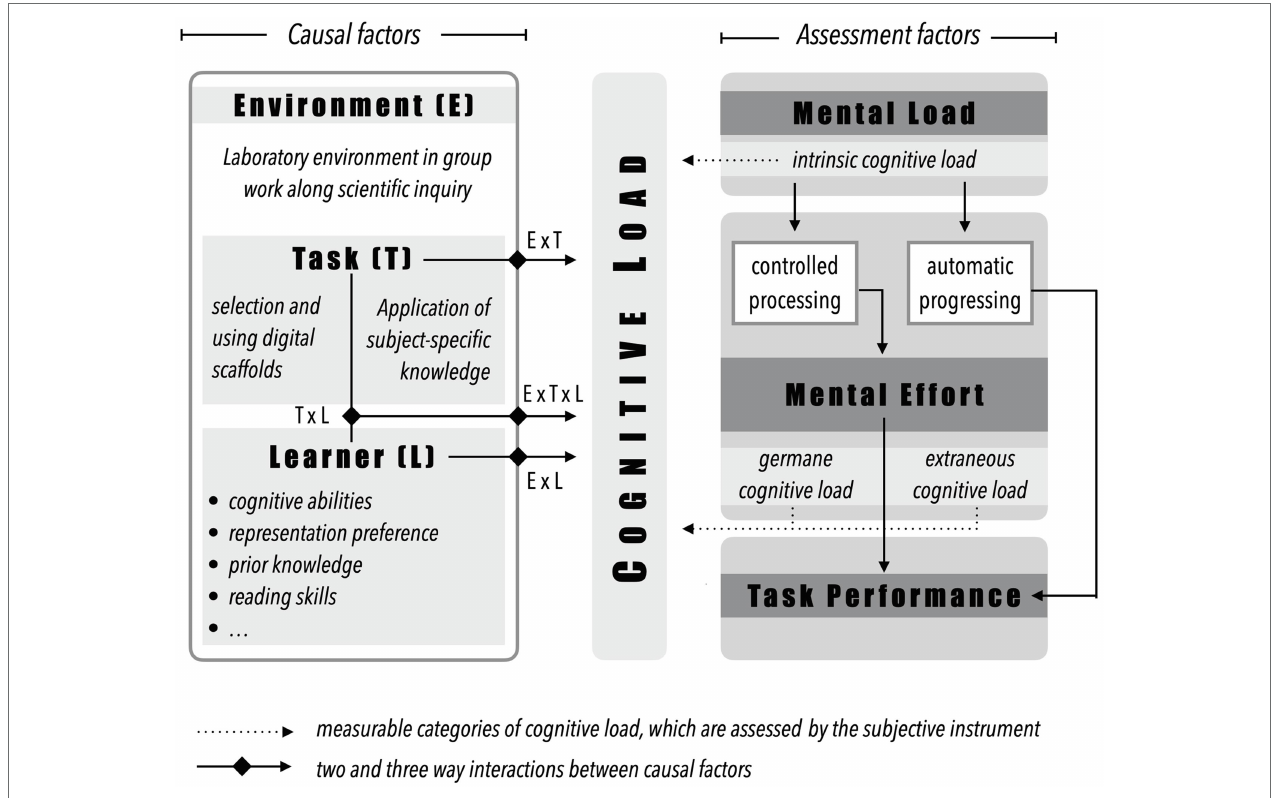
FIGURE 1 | Construct of cognitive load with for the study-specific causal and assessment factors (adapted from Choi et al.,